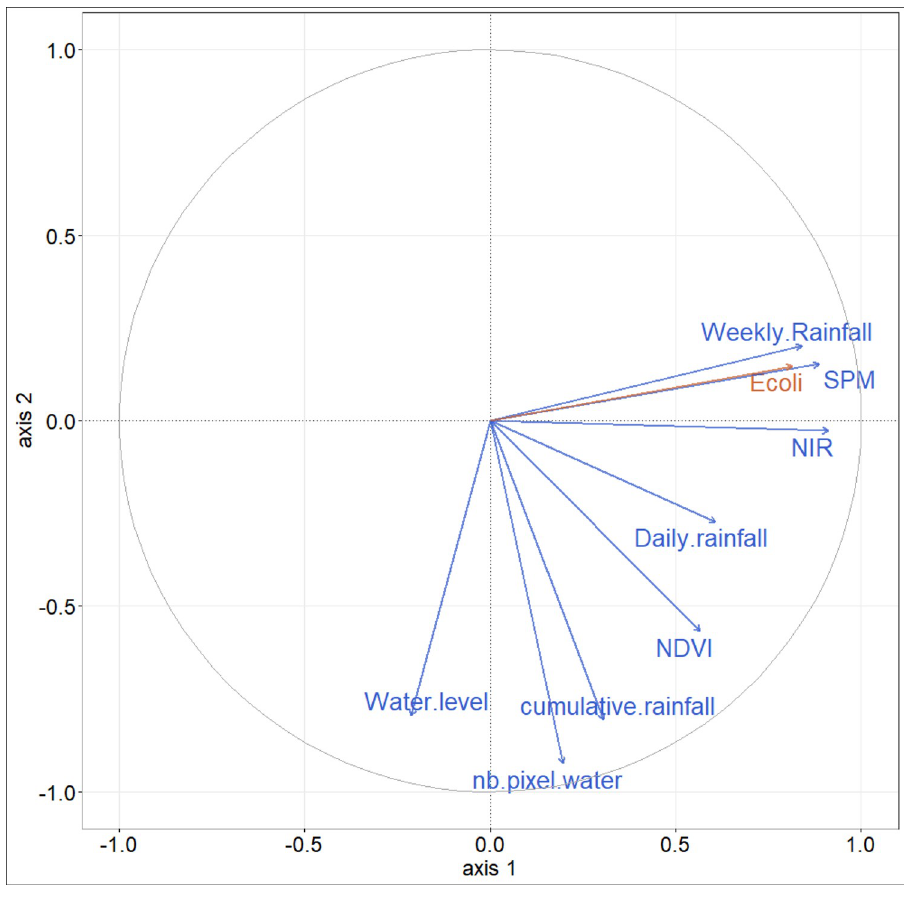
Fig 7. Correlation circle of partial least squares (PLS) regression, illustrating relationships between predictor variables (blue), E . coli (orange) and the two first PLS components (first component on the x-axis, second one on the y-axis).